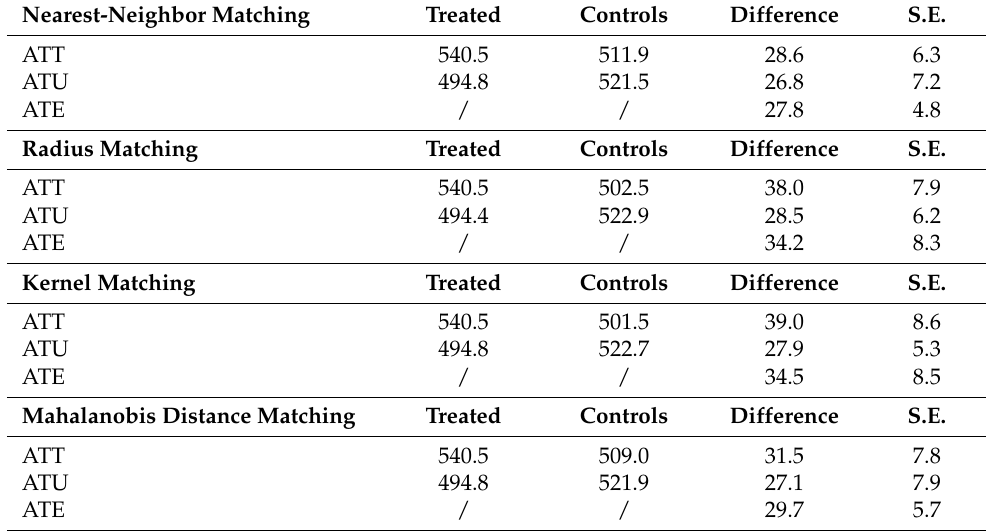
Table 8. Estimated processing effect of different matching methods for fifth-grade samples. Nearest-Neighbor Matching